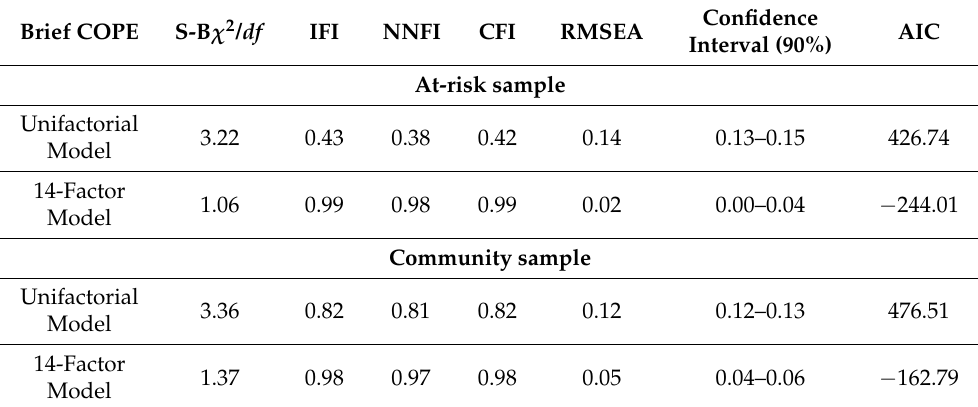
Table 1. Goodness of Fit Indices for ML Models.